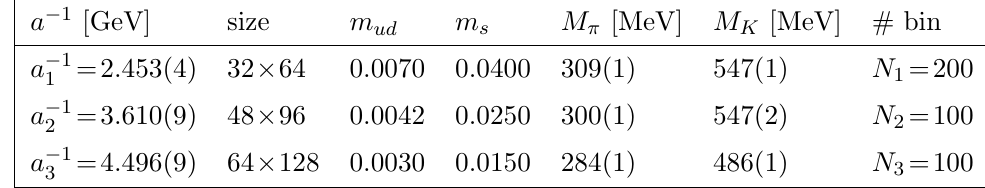
Table 1 . Lattice simulation parameters. For the quark masses m ud and m s , we list bare values in lattice units. The renormalization factor to the MS scheme is available in ref.